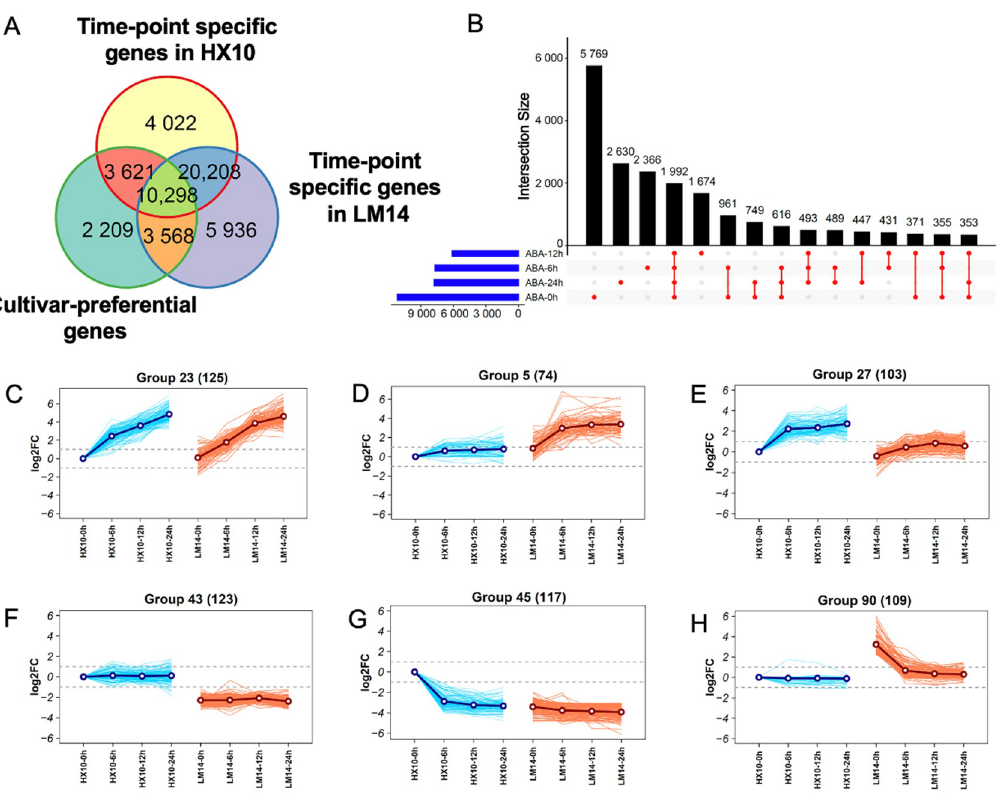
Figure 4. Time-point specific and cultivar-preferential expression patterns of ABA-responsive genes. ( A ) The Venn diagram shows the time-point specific genes in LM14, time-point specific genes in HX10, and cultivar-preferential genes. ( B ) The histogram shows the DEGs obtained by comparing different time points of ABA treatment. ( C – H ) ABA-induced, repressed, and background expression patterns in LM14 and HX10. Light blue and red lines indicate the log 2 values of the relative expression changes of the genes between the expression levels of untreated HX10 samples and those of other samples. The bold lines indicate the average log 2 values at each sampling point. The Y-axis shows the log 2 fold-change (FC).